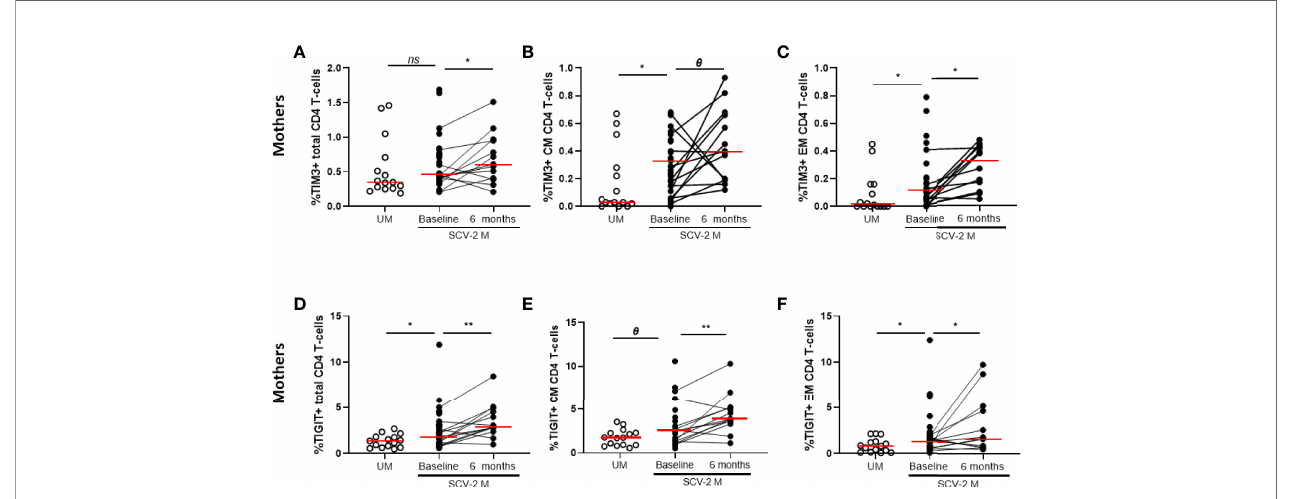
FIGURE 4 | Exhaustion markers on CD4 T-cells subsets. TIM-3 expression in total CD4 T cells (A) and in Central and Effector Memory (CM and EM, respectively) (B, C) and TIGIT expression in total (D) and CM and EM CD4 T cells (E, F) . Mann-Whitney U-test was used to compare groups. Wilcoxon test was conducted to compare paired events. SCV2-M, SARS-CoV2 mothers ’ group; UM, Uninfected mothers ’ group. **p ≤ 0.01 , *p<0.05 , Ɵ 0.05 ≤ p ≤ 0.1 , ns p>0.1